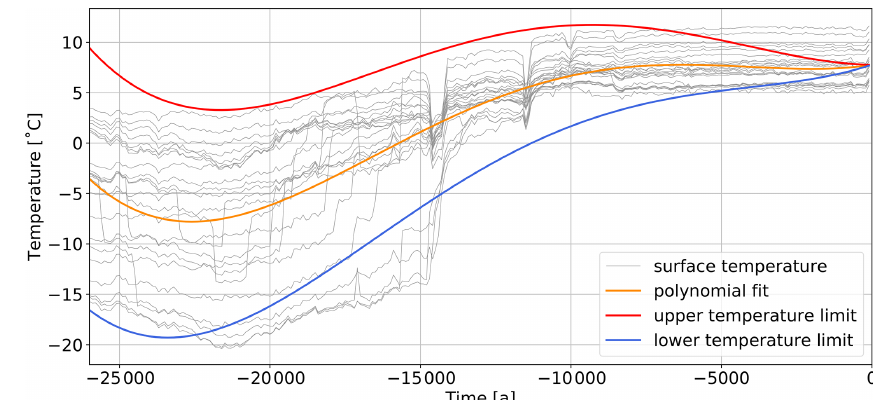
Figure 10. Trend for the paleotemperature upper boundary condition of the CEBS model.